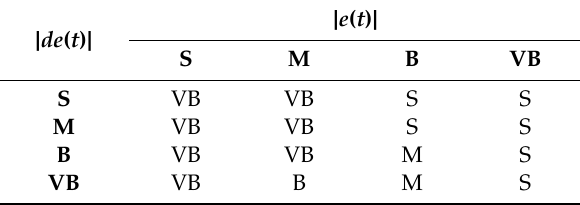
Table 3. Fuzzy rule of K d